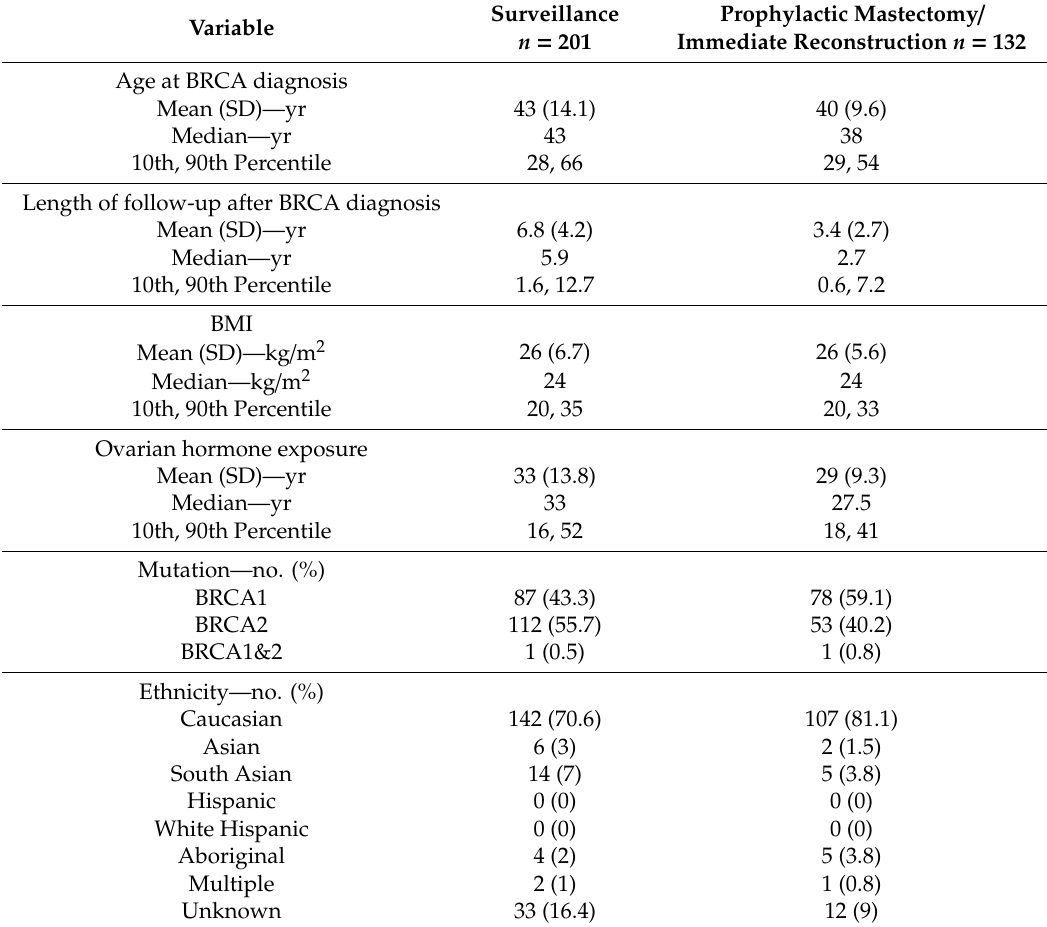
Table 1. Patient